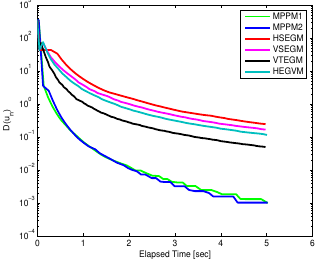
Figure 7. Methods for Example 3 with m = 2. Number of iterations is 49, 57, 56, 52, 94, 54, respectively.